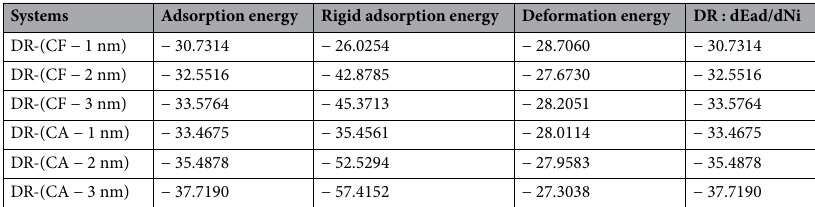
Table 5. Adsorption energies (kcal/mol) for the adsorption configurations of DR adsorbed on chitosan-4- chloroacetophenone Schiff base, 5–10 units.